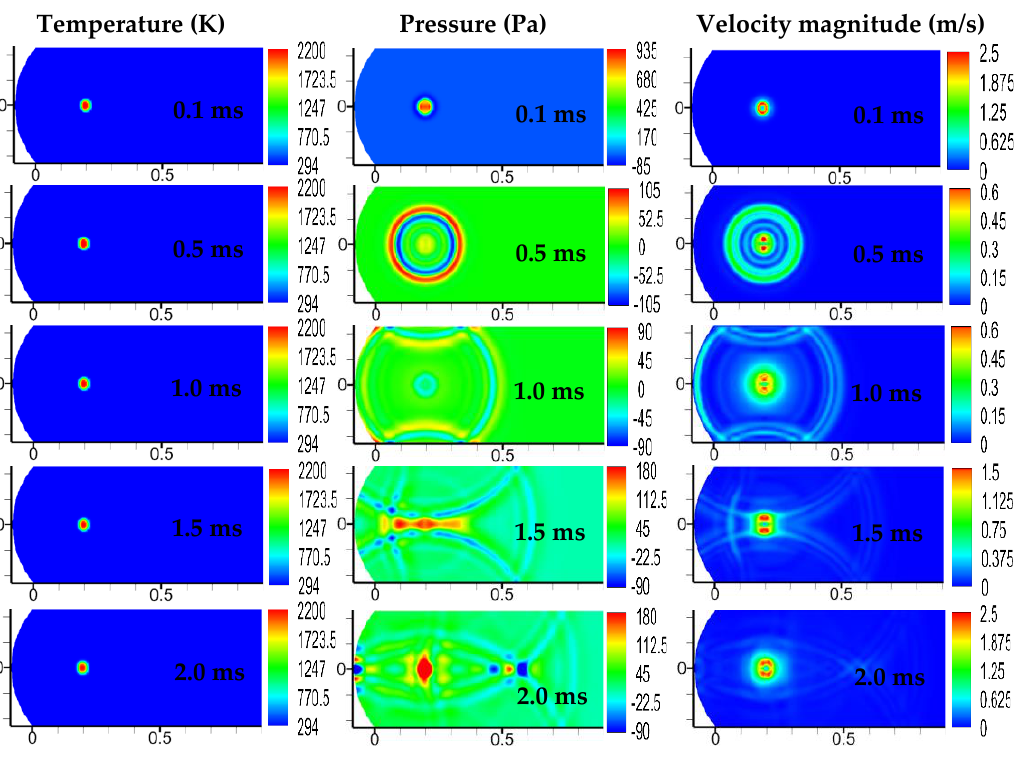
Figure 5. Flame propagation after explosion occurs in an empty tube.